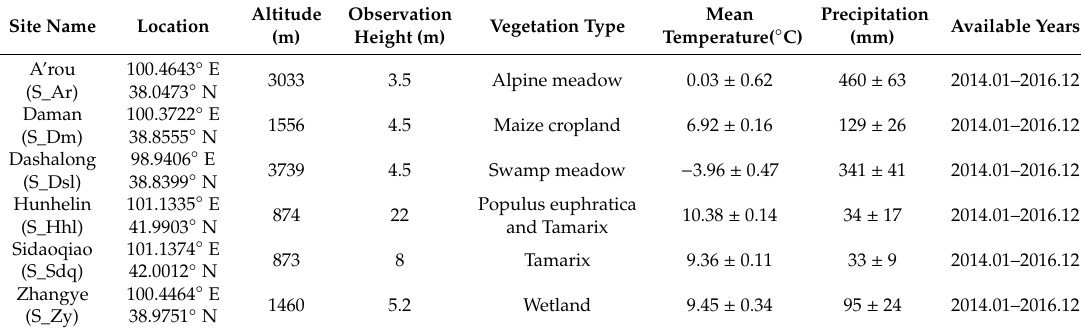
Table 1. Descriptions of the flux sites used in this